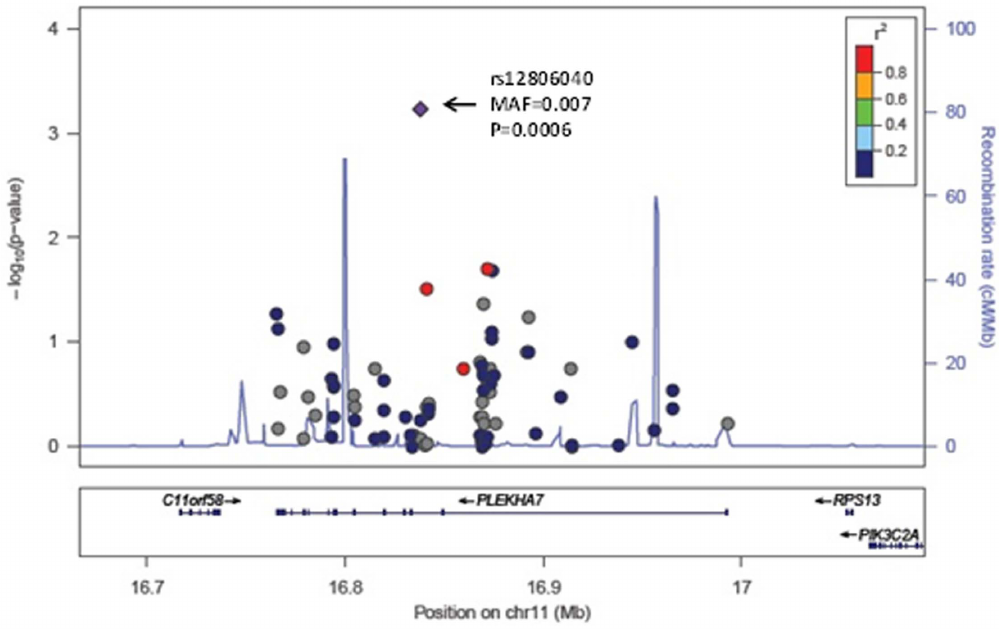
Figure 4. Regional association plot for PLEKHA7 in relation to DBP. Each circle represents a single variant. The triangle denotes the index variant. The color coding corresponds to the correlation (r 2 ) between index variant and the other variants.